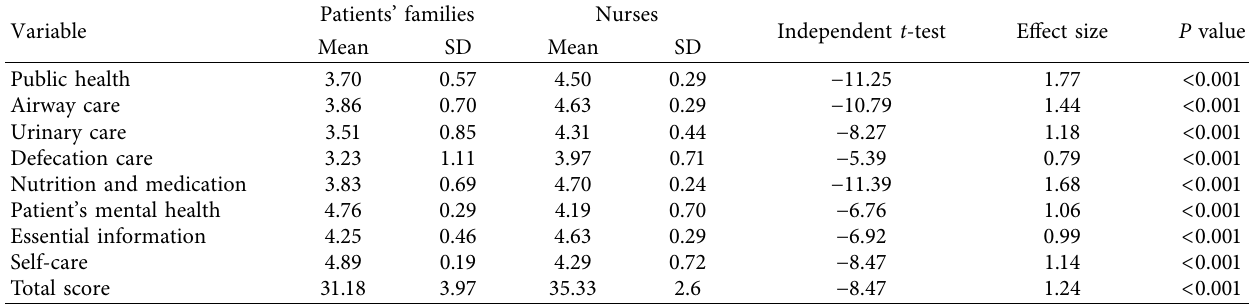
Table 1: Comparing mean scores of educational needs of the families of patients discharged from ICU and their dimensions from nurses and families’ points of view.